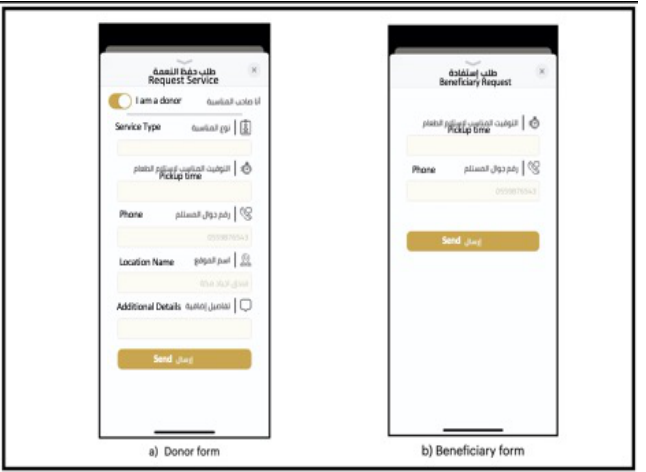
Figure 1. User locating interface.